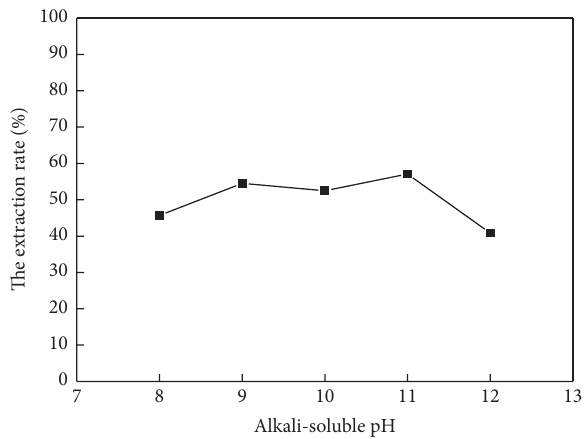
Figure 3: Effect of alkali solution pH value on the extraction rate of saponin (liquid-solid ratio 10mL/g, extraction temperature 60 ∘ C, extraction time 60 min, and acid isolation pH value 3).